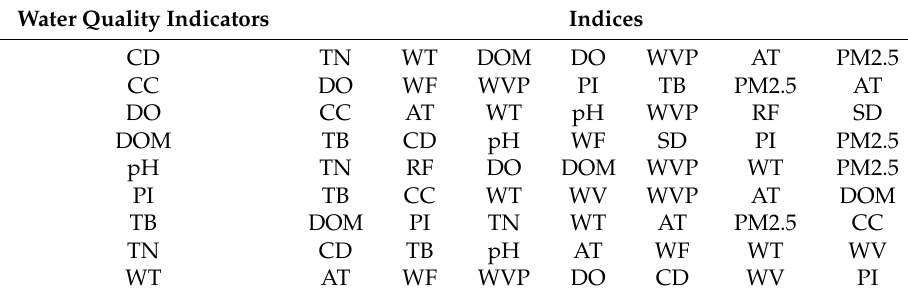
Table 4. The results of predictors selection for each water quality